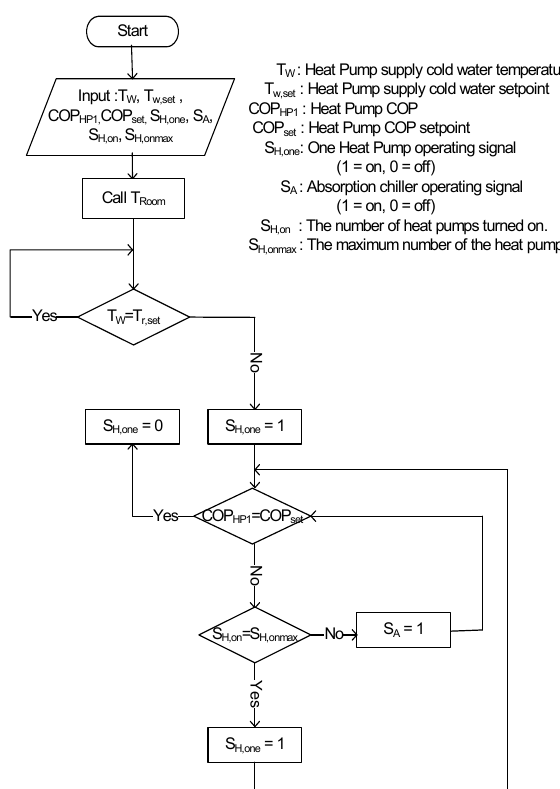
Figure 9. Hybrid operation method for GHP system and absorption chiller ‐ heater.